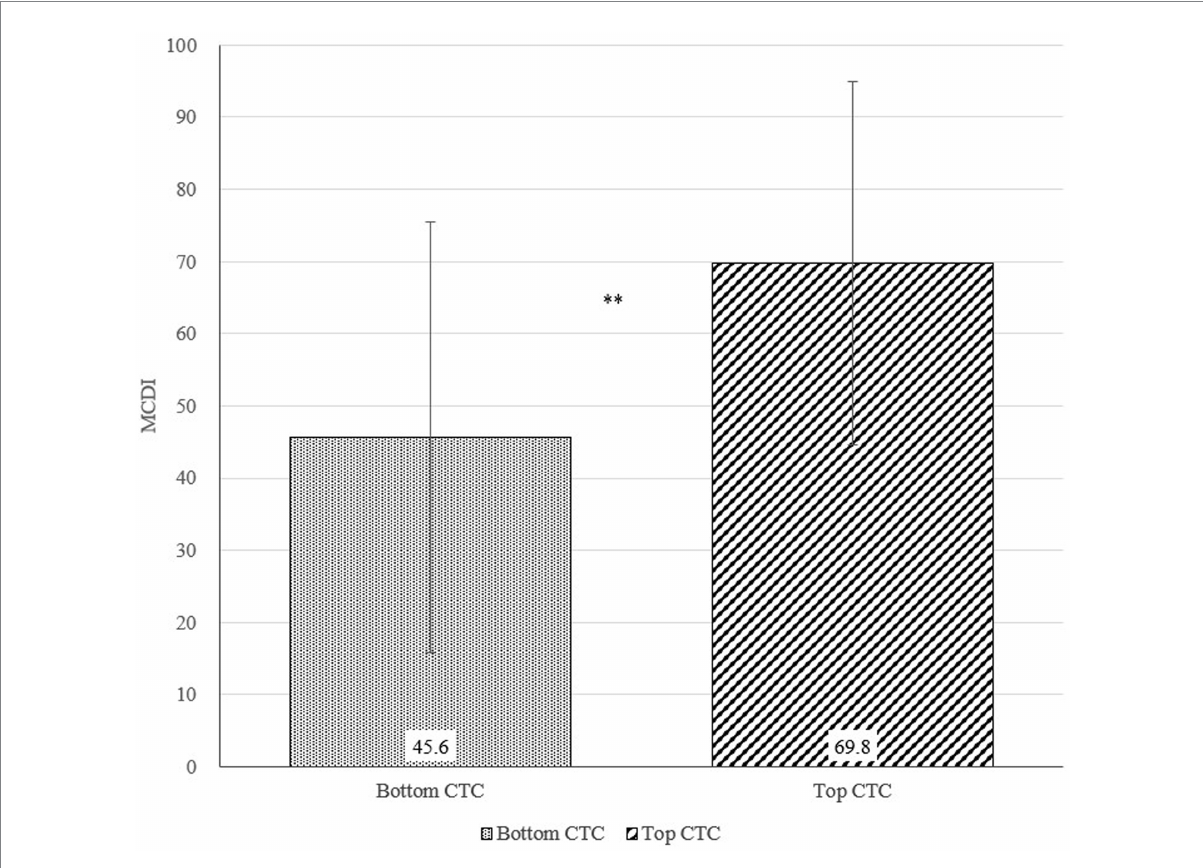
FIGURE 7 Differences in MacArthur-Bates Communicative Development Inventories (MCDI) scores between top and bottom terciles of Conversational Turn Count (CTC; p -value =